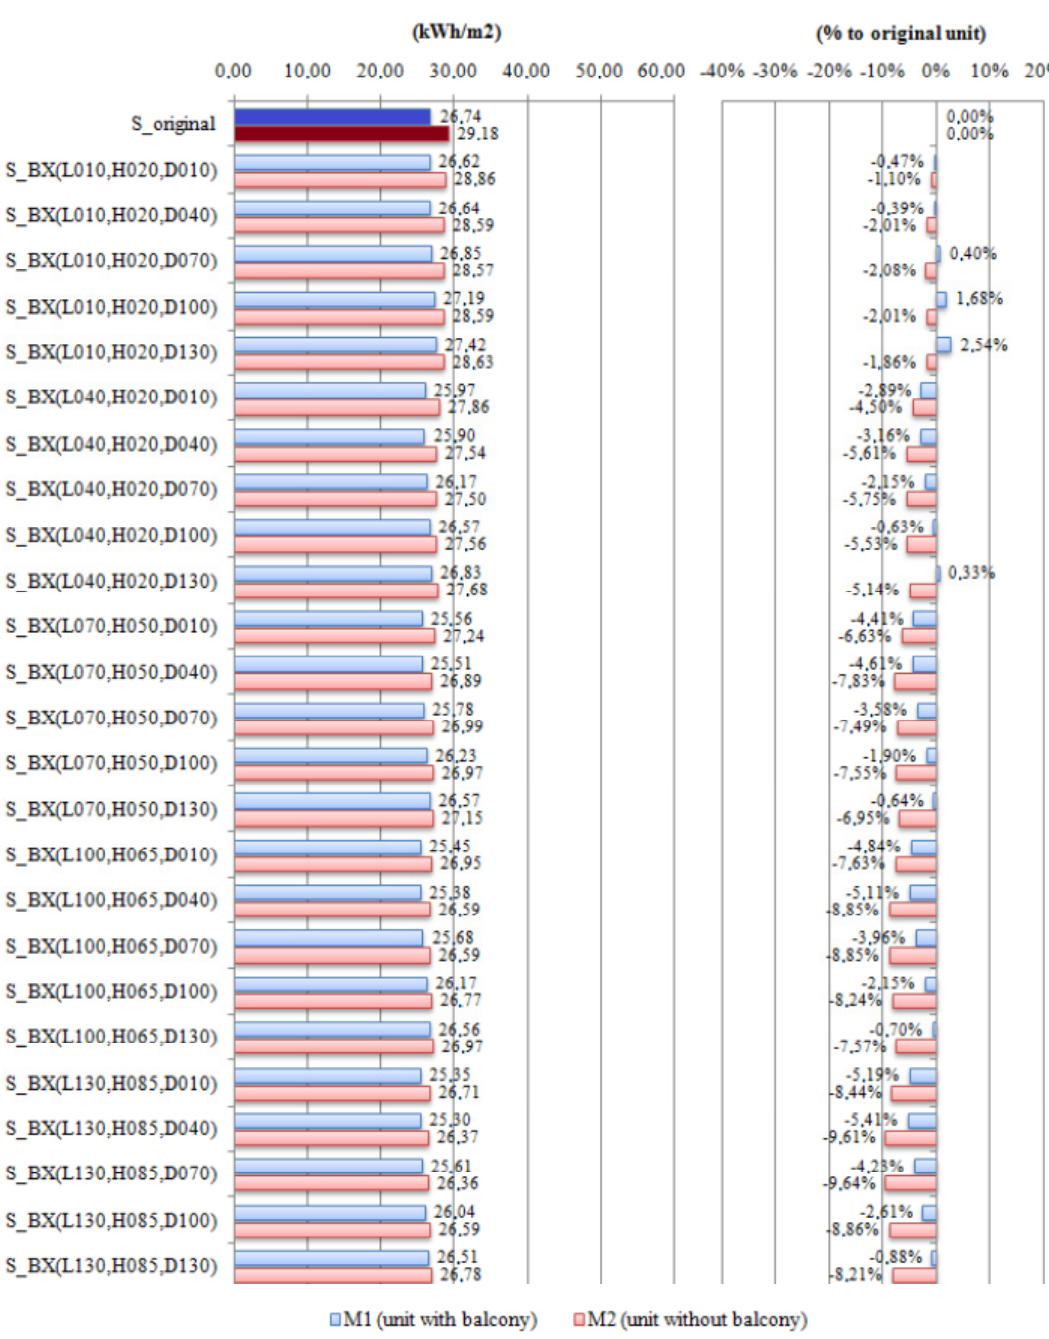
Figure A1. BX Series : Annual thermal